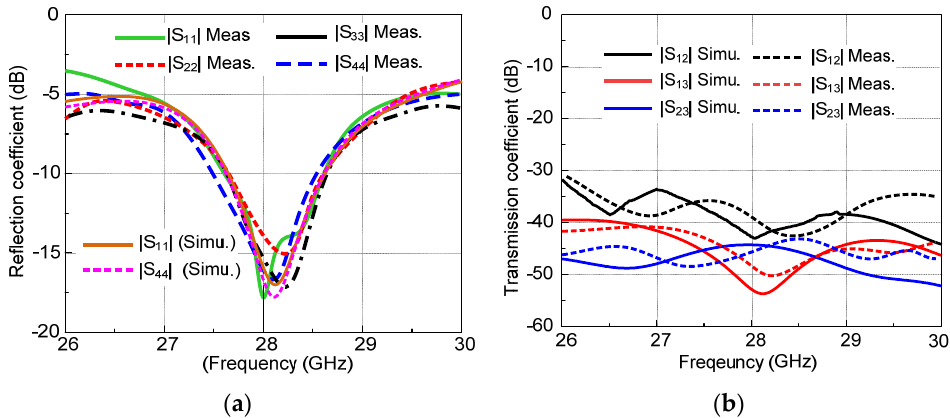
Figure 10. Measured and simulated s-parameter plots. ( a ) Reflection coefficient; ( b ) Transmission coefficient of the proposed MIMO antenna.